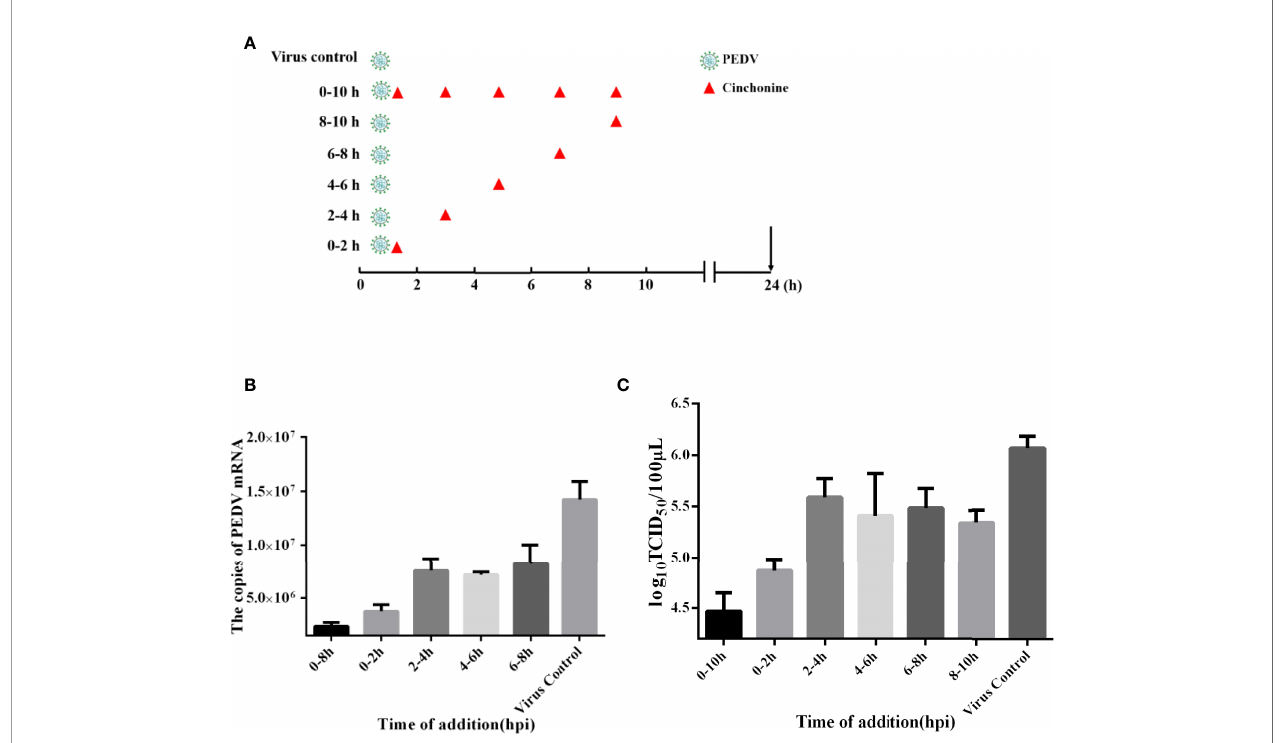
FIGURE 3 | Time-of-addition effect of cinchonine on PEDV replication in Vero CCL81 cells. (A – C) Vero CCL81 cells were infected with the PEDV, and 100 m M cinchonine was added into infected cells at different time periods of PEDV infection: 0-10, 0-2, 2-4, 4-6, 6-8 and 8-10 h At 24 h, samples were prepared and examined with the quantitative real-time PCR and TCID 50 assay. PC: virus control without cinchonine treatment. The data has been presented as the mean ± SD of at least three independent